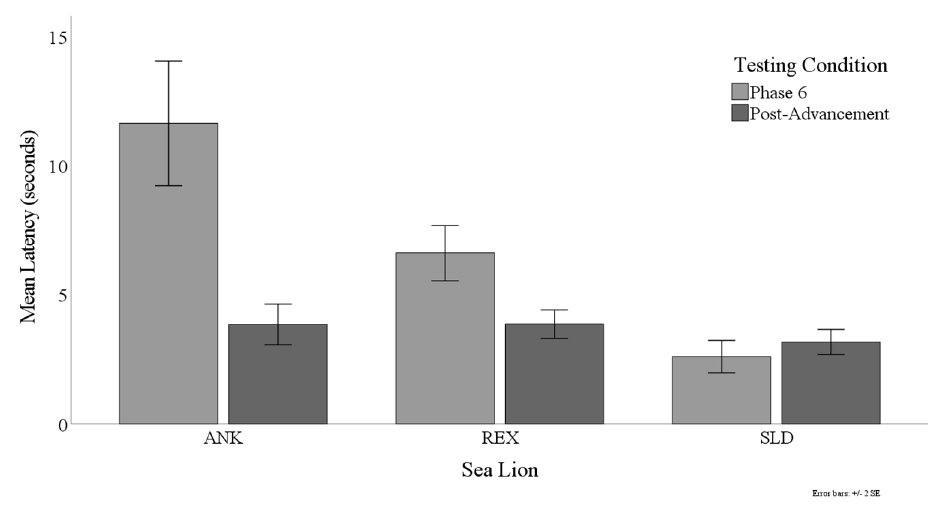
Figure 6. Mean (±2 SE) trial latency among sea lions and across testing conditions. Figure 6. Mean ( ± 2 SE) trial latency among sea lions and across testing conditions.